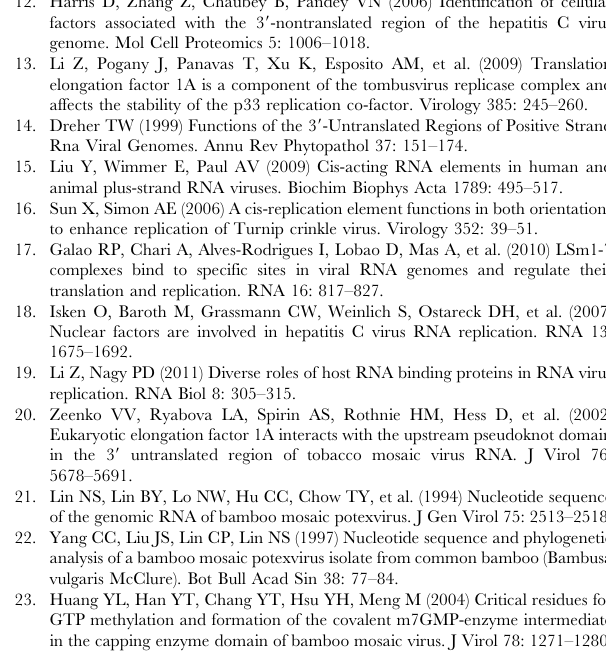
Figure S1 Schematic representation of the secondary structures of the 3 9 UTRs of BaMV, satBaMV, and PVX. ( A ) The secondary structure of the BaMV 3 9 UTR, established by enzymatic and chemical probing, comprises four stem-loops (domains A, B, C, and D) and a pseudoknot (Domain E) [27]. ( B ) The secondary structure of the satBaMV 3 9 UTR, confirmed by enzymatic probing, comprises stem-loops A, B and C [29]. ( C ) The secondary structure of the PVX 3 9 UTR, established by enzymatic and chemical probing, consists of stem-loops 1, 2 and 3 [58]. (TIF) Figure S2 Comparison of the NbHsp90 amino acid sequences with those of three known isoforms. The full- length amino acid sequences of all published Hsp90 isoforms, NbHsp90-1, NbHsp90-2, and NbHsp90-3, and that of the clone from our lab, NbHsp90, were aligned using CLUSTAL W. The alignment output is ordered by the similarity between NbHsp90 and NbHsp90-1, -2, and -3. NbHsp90 is most similar to NbHsp90- 2. Residues are numbered below the alignment. Completely conserved residues from the 4 sequences are lettered in gray. Residues that are identical to NbHsp90 are lettered in black and similar residues are lettered in white over a gray background. Different residues are lettered in white over a black background. The black lines above the sequence show the peptides identified by MALDI-TOF MS. Figure S3 Knocking down Hsp90 expression in N. benthamiana reduces BaMV RNA accumulation. ( A ) Semi-quantitative RT-PCR analysis of Hsp90 mRNA levels in silenced (TRV1/TRV2-Hsp90) and non-silenced (TRV1/TRV2, Mock, and TRV1/TRV2-PDS) plants. Actin mRNA was used as an internal control. Lane NC represents the negative controls in which the reverse transcriptase-free RT reaction mix was used as a template in the PCR reaction (36 cycles). ( B ) Quantification of the relative accumulation of BaMV, PVX, and CMV viral RNA in